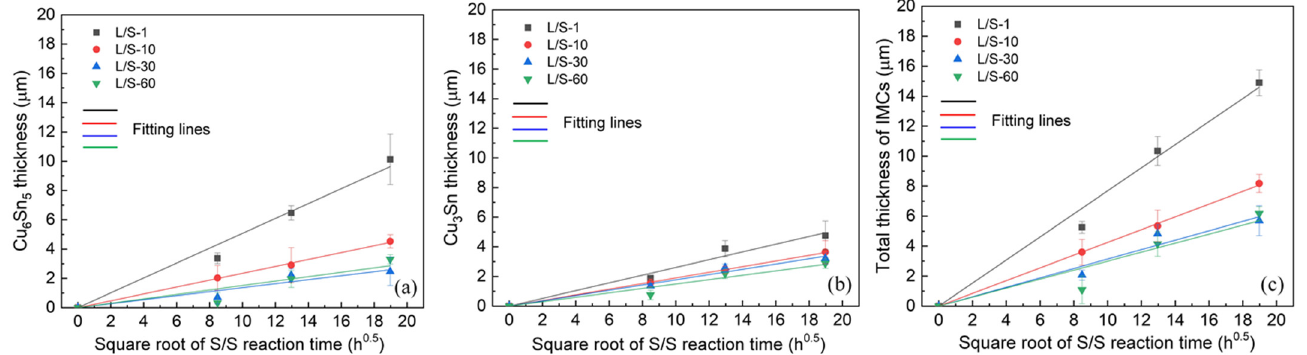
Figure 5. Thicknesses of the IMCs as a function of the square root of reaction time for various liquid/solid joints: ( a ) Cu 6 Sn 5 , ( b ) Cu 3 Sn, and ( c ) Cu 6 Sn 5 + Cu 3 Sn. Table 2. Growth rate constants ( k ) of Cu 6 Sn 5 , Cu 3 Sn, and Cu 6 Sn 5 + Cu 3 Sn for thermal aging (solid/solid) reactions at 200 °C (unit: µm/h 0.5 ).